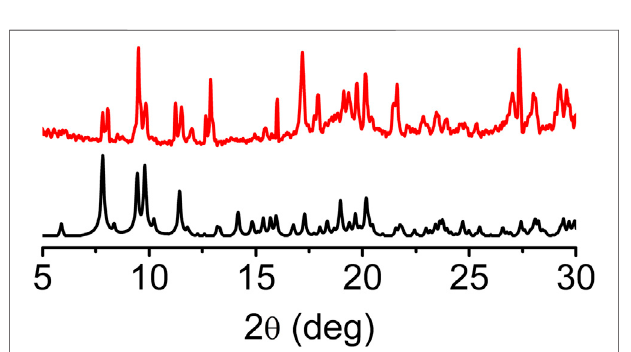
FIGURE 2 | PXRD pattern of pristine sine -MOF showing retention of the crystallinity after activation.